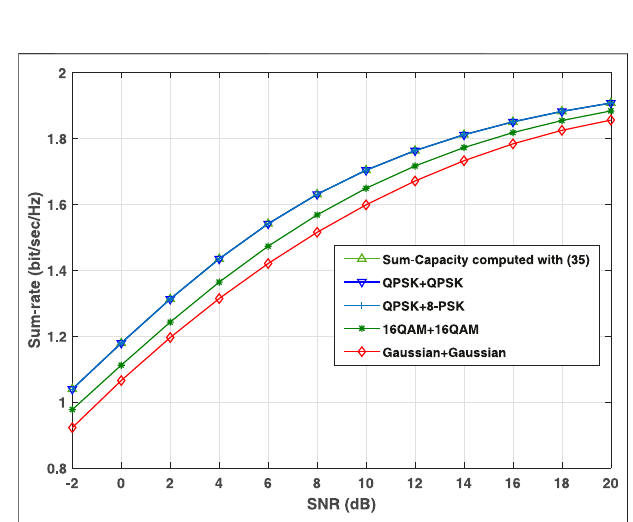
FIGURE 5 | Sum-rates achieved by different pairs of input signals over the 2-term GM MAC. The two users are assumed to have unequal transmit power P 1 (cid:2) P and P 2 (cid:2)